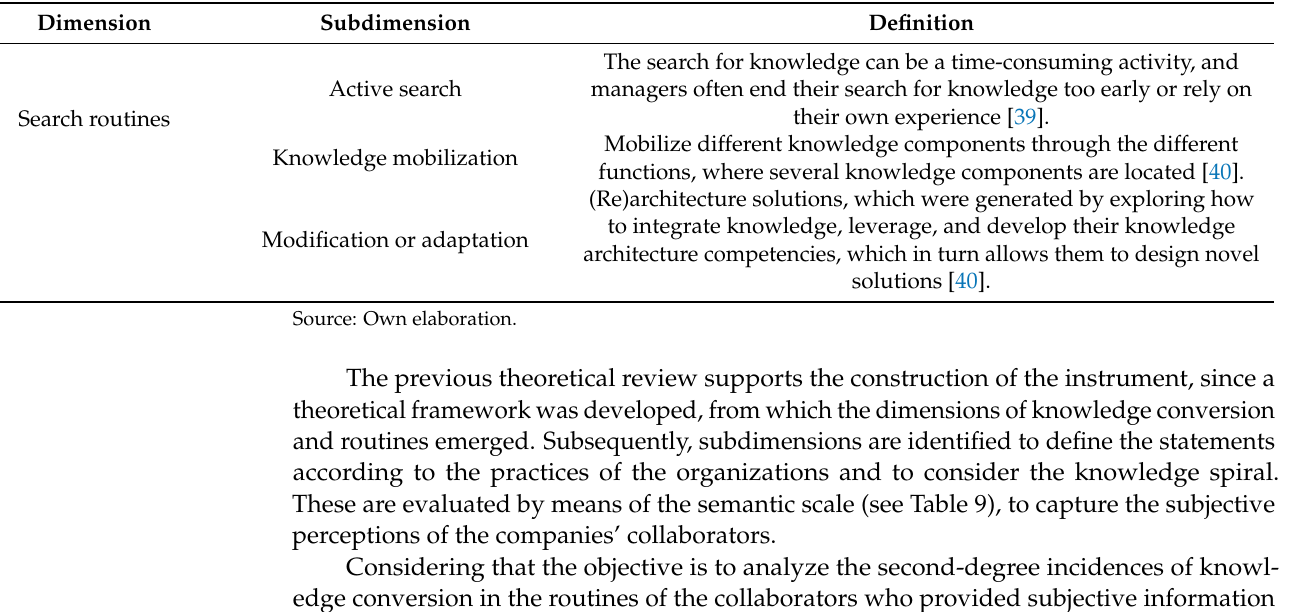
Table 6. Dimension of search